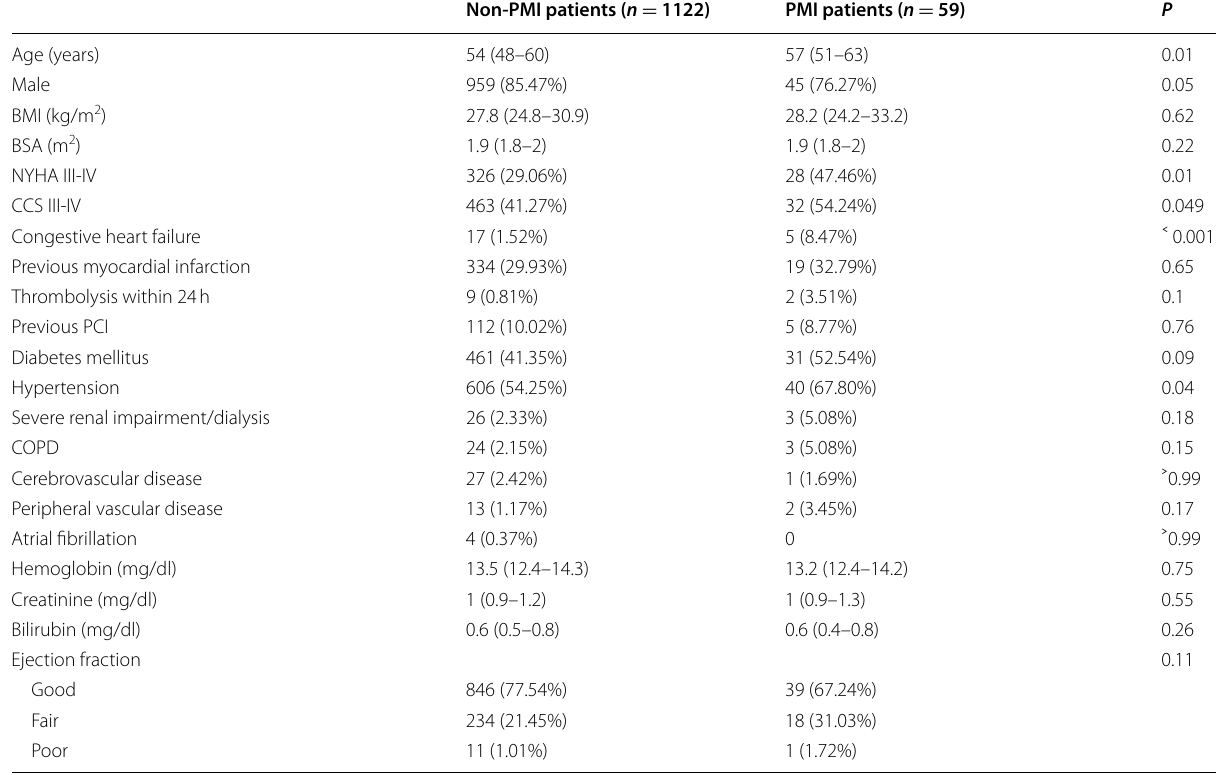
Continuous variables were presented as mean and standard deviation if normally distributed and median (25th–75th percentiles) if not normally distributed. Categorical data were presented as frequencies and percentages